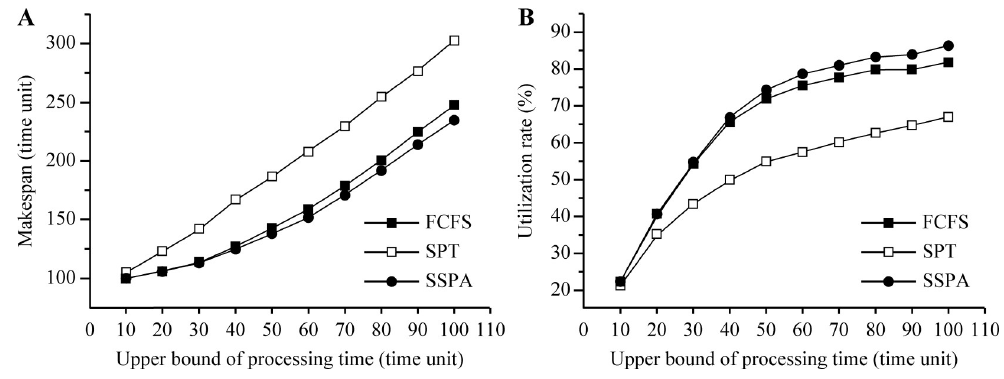
Fig 8. Results for variable upper bound of processing time. (a) Makespan and (b) utilization rate.